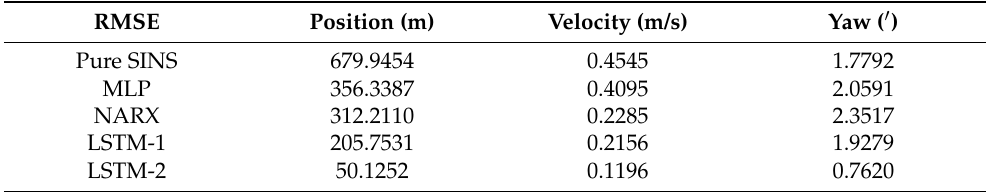
Table 5. Integrated navigation position, velocity, heading error table.